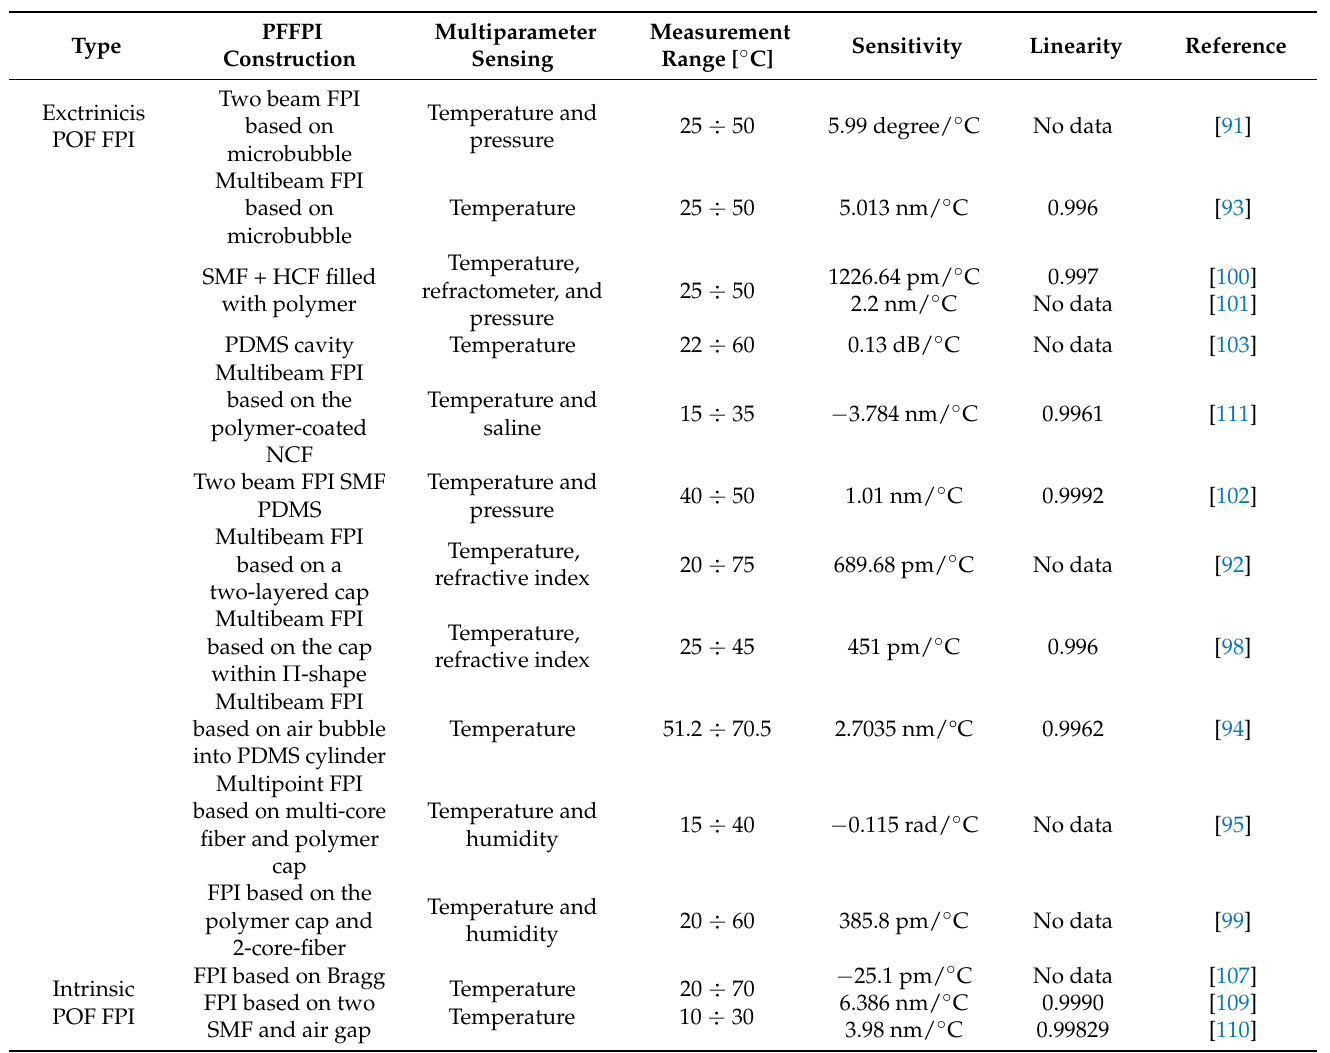
Table 1. Type of the POF temperature